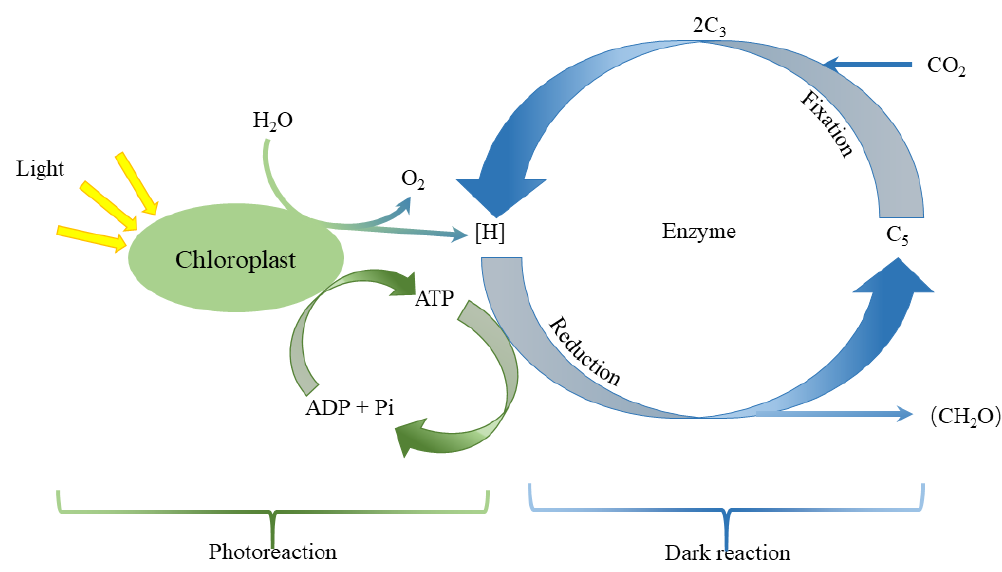
Figure 7. Mechanism of plant photosynthesis.